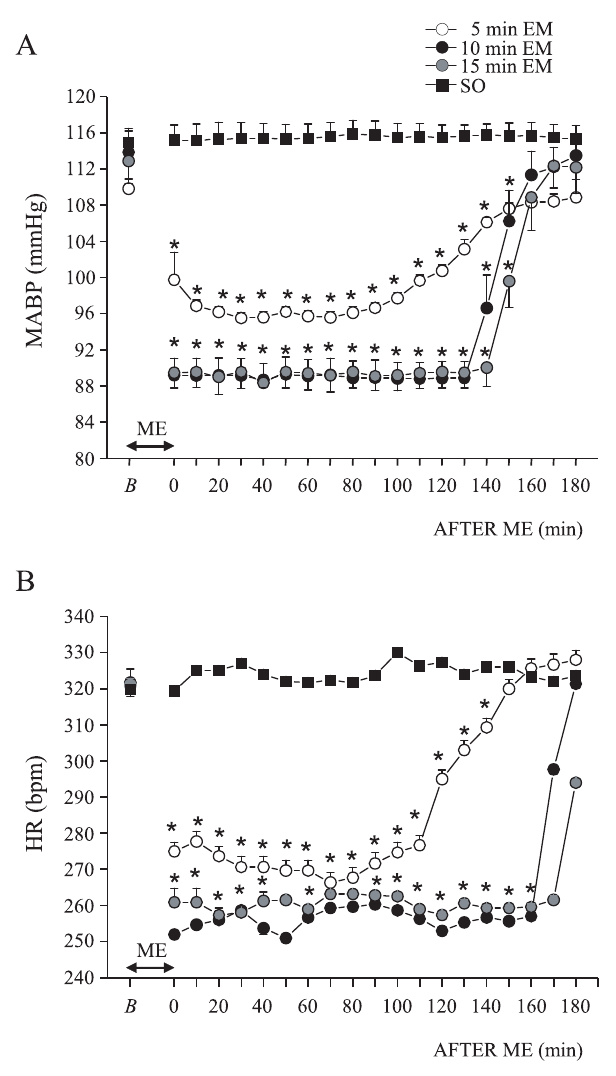
Fig. 2. ME of different durations induced a reduction of MABP and HR. MABP(A) and HR (B) were recorded before ( B ) and after ME. ME of different durations induced an immediate significant reduction of MABP in comparison with the baseline value lasting for 140 minutes after 5 minutes ME (n 5 5 rats, open circle) and for 160 minutes after 10 or 15 minutes ME (n 5 5 rats, filled circle and n 5 5 rats, grey circle respectively). In control rats (n 5 5 rats, SO) MABP did not change for the whole observation period (filled square). HR significantly decreased immediately after removing ME of different durations. After 5 minutes ME, HR persisted significantly reduced up to 140 minutes (open circle), while after 10 (filled circle) or 15 minutes (grey circle) ME, HR was significantly decreased up to 160 minutes. In SO rats (filled square), HR was constant for the whole observation period. * Significantly different from the baseline